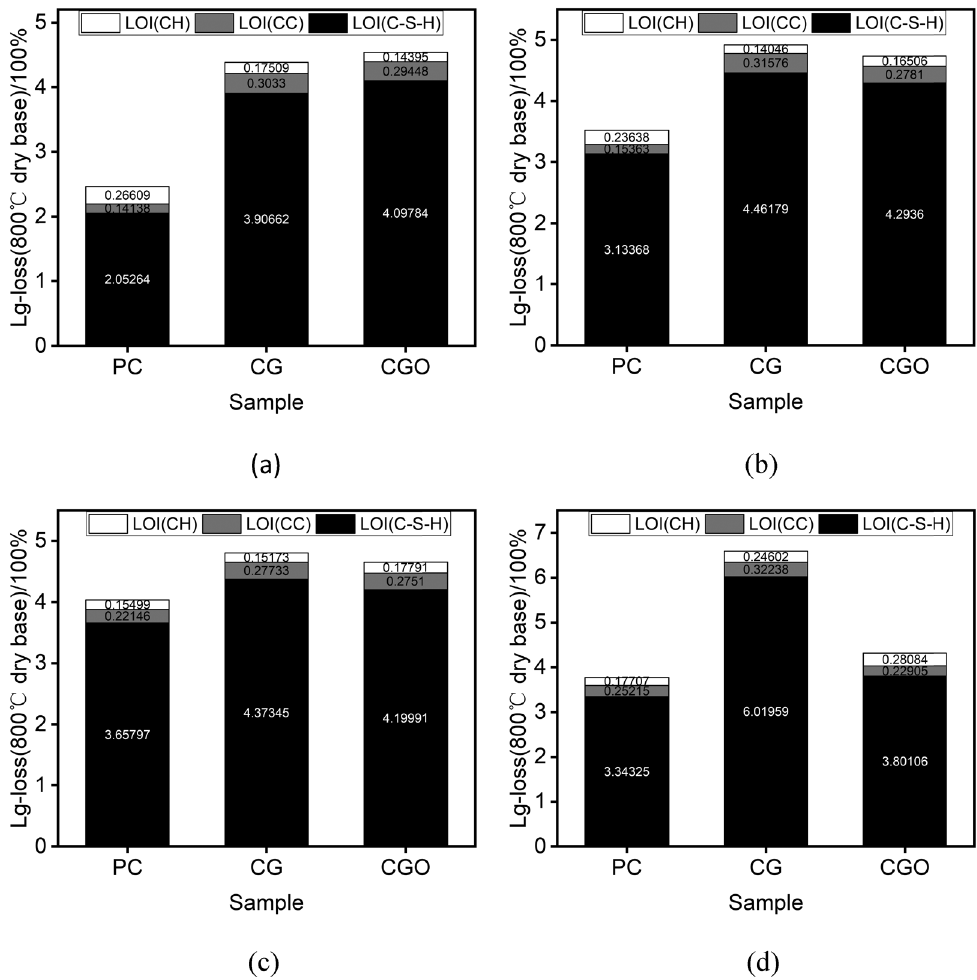
Figure 7: The relative content of the hydration products of the samples at 15 min ( a ) , 1 h ( b ) , 4 h ( c ) , and 7 h ( d )